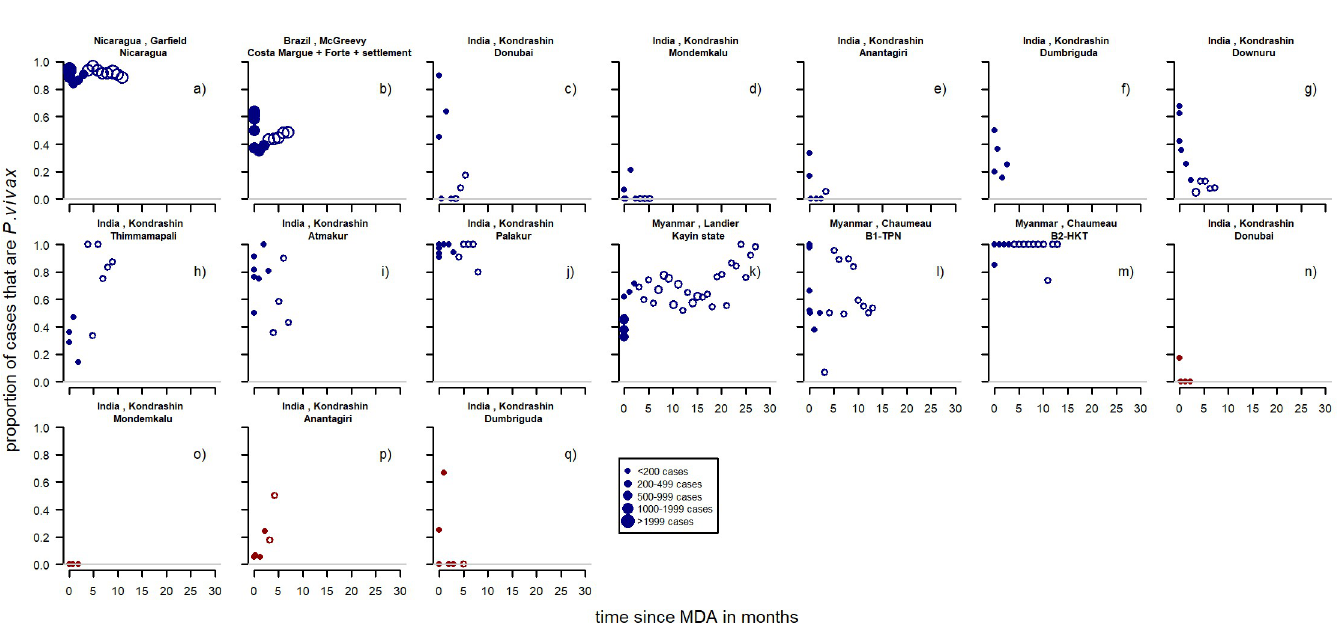
Fig 5. Proportion of clinical cases with P. vivax infection by time since MDA. Blue dots: first round of MDA, red dots: repeated MDA (first round took place 3–6 months before). Open circles: more than 3 months after MDA. Dot size depending on number of cases found Pre-intervention points as described in Methods (definition of variables: time since